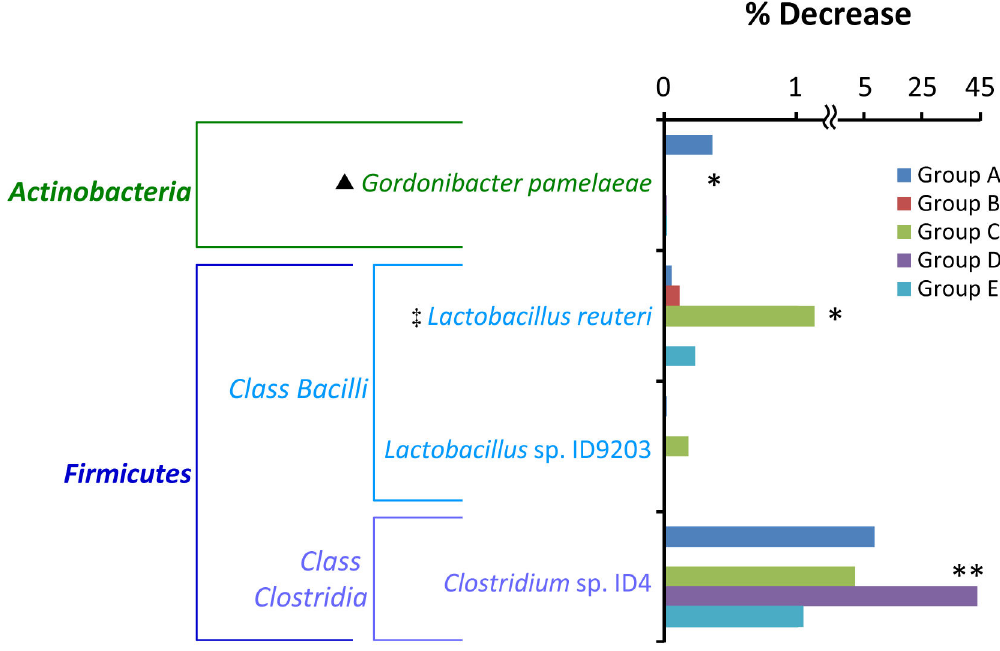
Figure 4. Bacterial phylotypes in the small intestine whose population level decreased upon PG-administration. Percent decrease was calculated by subtracting the percent population level of each specific phylotype found in the PBS control mice with that found in the PG-administered mice. Associations between bacterial phylotypes and PG administration were examined by Fisher exact test. The phylotypes having P values less than 0.05 at least in 2 groups (see Table S7) are shown. Asterisks * and ** indicate bacterial phylotypes having P values less than 0.05 in 3 and 4 groups, respectively. ‡: Bacteria with immunomodulatory effect, ▲: disease-associated